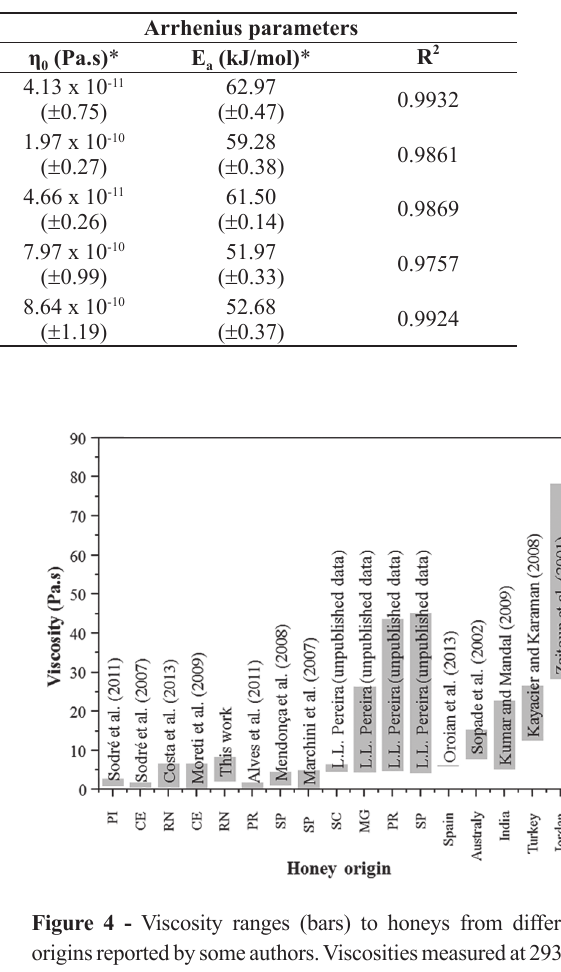
Arrhenius model parameters and viscosities at 293 K for honey samples.